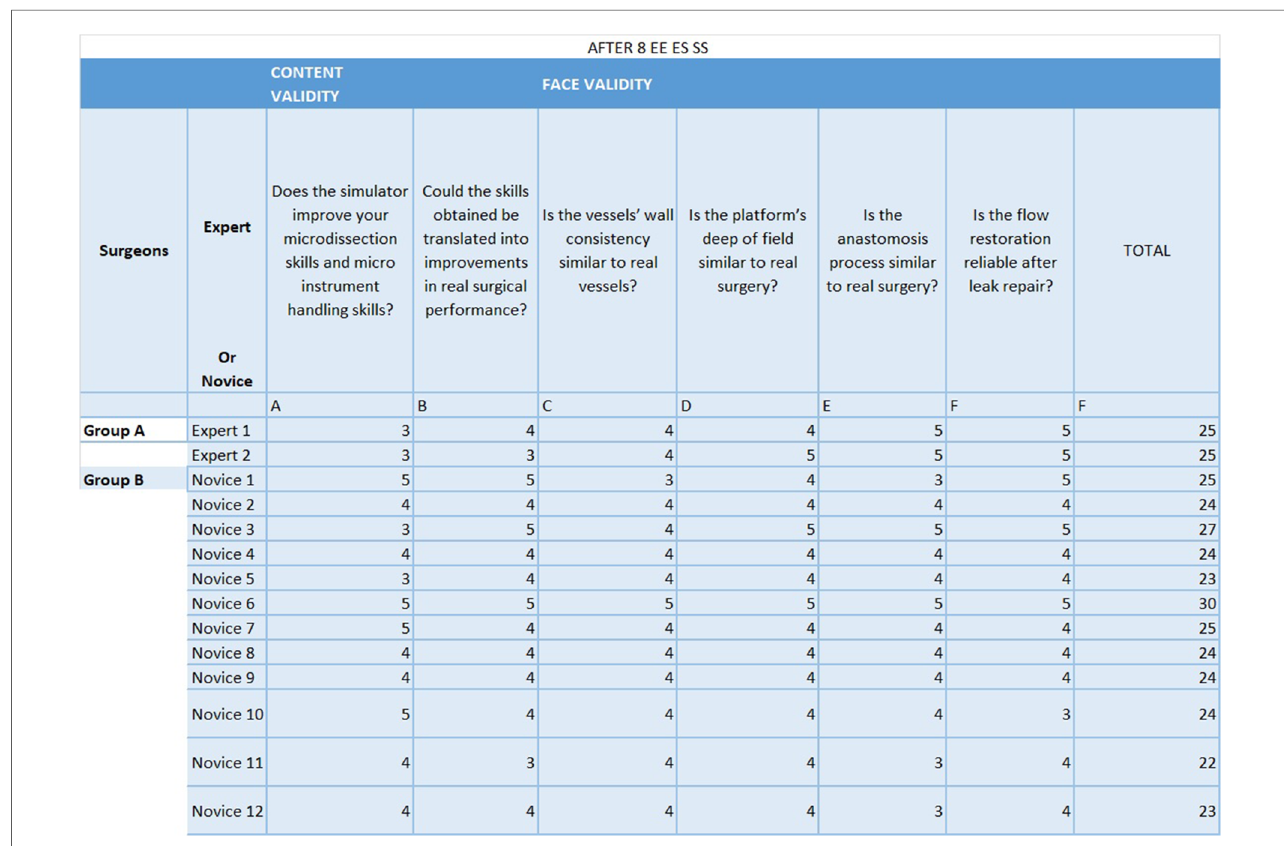
FIGURE 4 6-question Likert Like Survey. Each question was answered, after the 8th attempt by each of the partecipants, on a scale from 1 to 5: 5- exactly like; 4- very similar; 3 – similar; 2 – little similarity; 1 – not similar, with the statements provided. The fi rst four questions assessed face validity: the participants judged the degree of actual task replication and dif fi culty when compared to real surgery. The other questions appraised content validity, i.e. the potential of the training platform to upgrade their microdissection and microinstrument handling skills and the likelihood that this could determine improvements in their real surgical